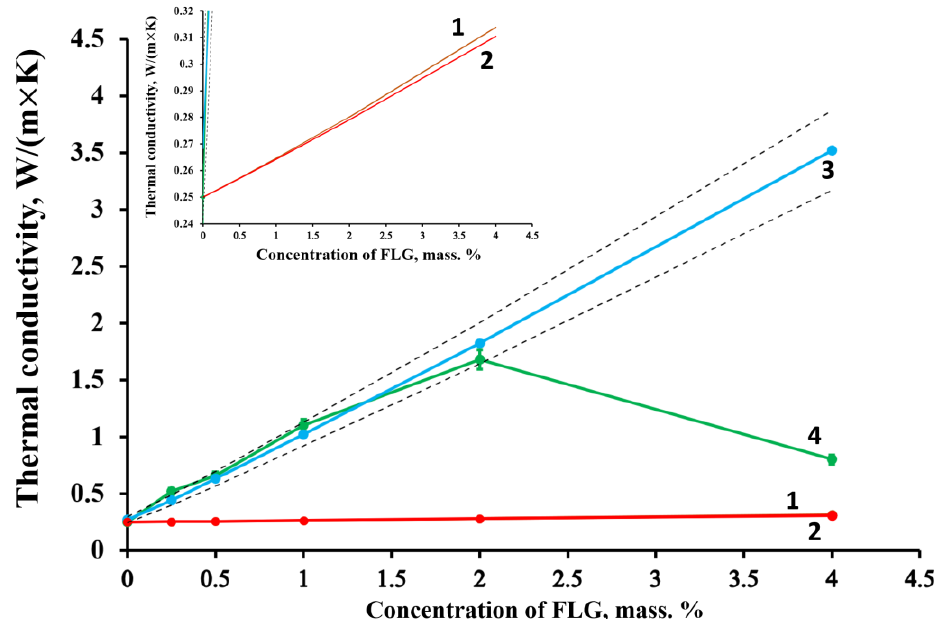
Figure 10. Comparison of experimental data with the results of calculations by models: 1 — geometric model; 2 — Maxwell model; 3 — MBE model; and 4 — experimental data. The dotted line shows a 10% deviation from the MBE model.